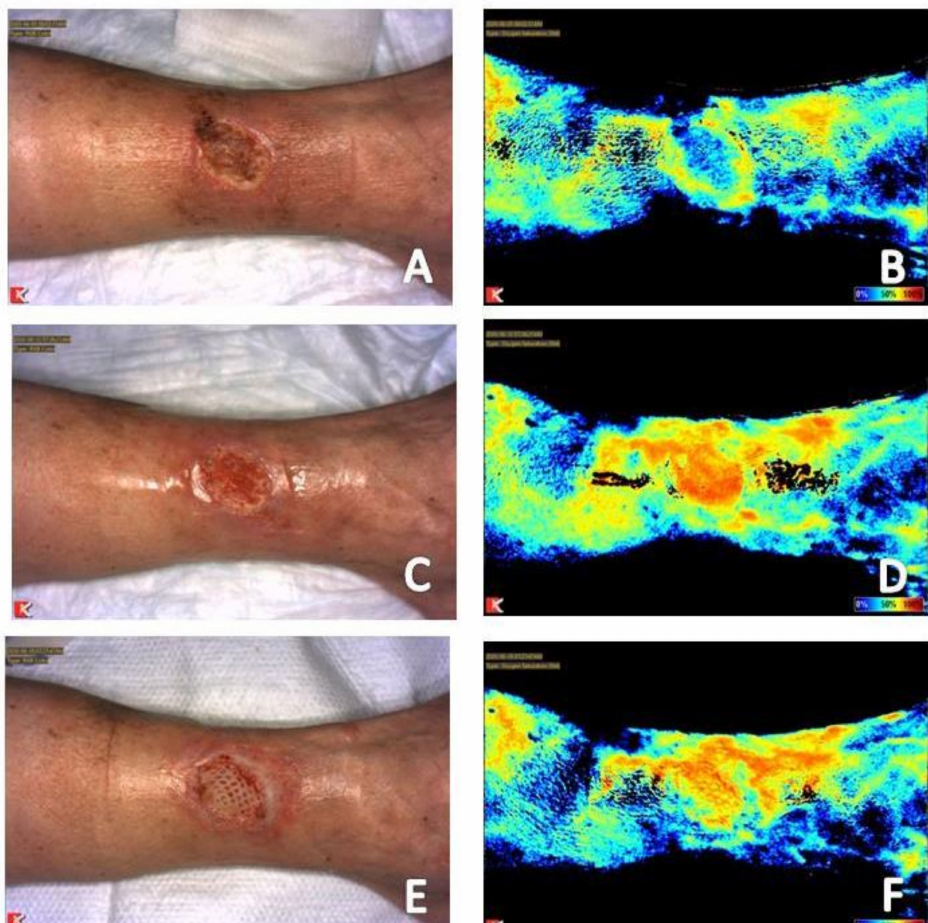
Figure 2. ( A ) Baseline clinical photograph; and ( B ) near-infrared image assessment of the right lateral leg. Note on the near-infrared image the increased signal (color closer to 100% on rainbow scale on near-infrared image) in the periwound area and reduced signal with the wound bed, indicative of